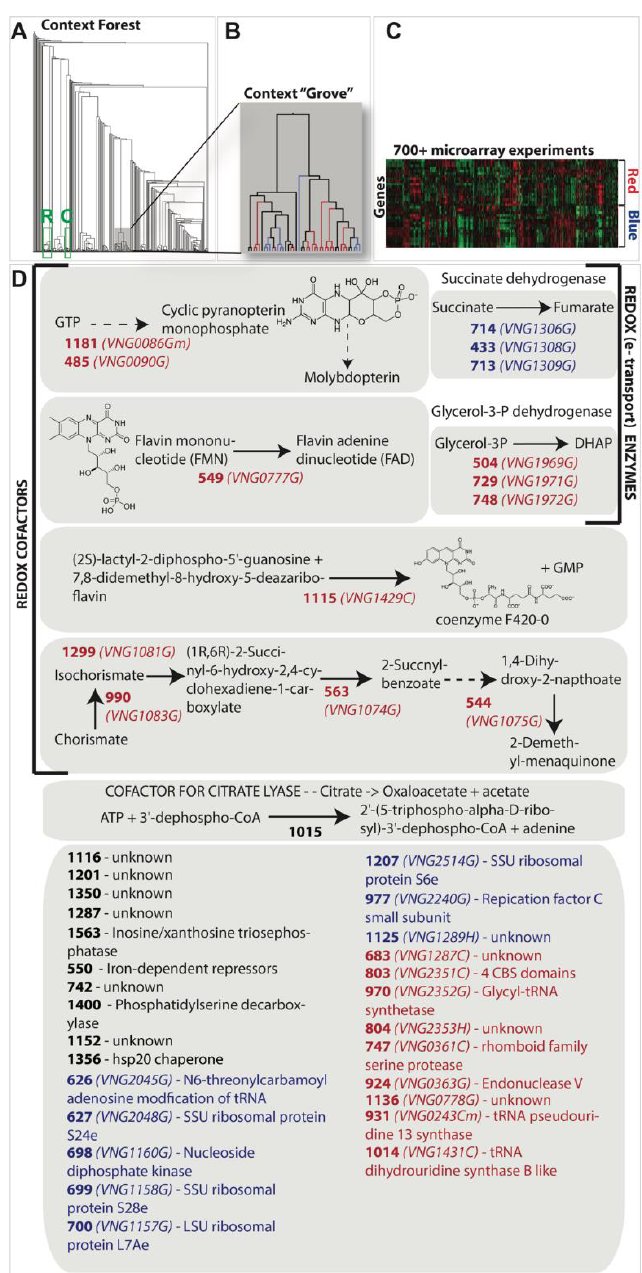
Figure 8. An in-depth analysis of one context grove generated from an analysis of OLS in the haloarchaea. ( A ) The tree at the top left shows the resulting context forest. A green box labeled “R” represents a ribosomal gene grove while the green box labeled “C” represents a cobalamin operon grove. ( B ) The tree immediately to the right of the context forest is an enlarged view of one context grove. ( C ) The heat map (top right) shows the patterns of transcriptional abundance for the genes found in this specific grove that are encoded in Halobacterium salinarum NRC-1. The expression data are derived from publicly available microarray datasets [48–55] . The data have been clustered and are found to be most parsimoniously described by two clusters of expression termed here Red and Blue. ( D ) When a gene present in the grove of panel B was also found in H. salinarum NRC-1, its expression cluster membership (panel C) is mapped on the branches and leaves of the context grove and in the cluster/gene names in the figure below by coloring the branch and/or gene name either Red or Blue. Gene names and annotations are labeled with cluster number in bold and H. salinarum NRC-1 geneID in italic. Cluster numbers colored black and lacking a geneID were not found in the H. salinarum NRC-1 genome.